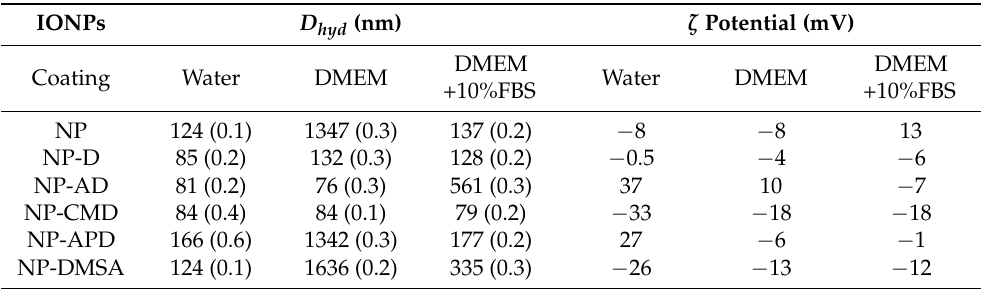
Table 1. Mean hydrodynamic diameters (with PDI in parentheses) and zeta potential values of IONPs suspended in water, DMEM cell culture medium and DMEM supplemented with FBS (10%). IONPs D hyd (nm) ζ Potential (mV) DMEM Coating Water DMEM Water DMEM +10%FBS NP 124 (0.1) 1347 (0.3) 137 (0.2) − 8 − 8 13 NP-D 85 (0.2) 128 (0.2) − 0.5 − 4 − 6 NP-AD 81 (0.2) 76 (0.3) 561 (0.3) 37 10 − 7 NP-CMD 84 (0.4) 84 (0.1) − 18 NP-APD 166 (0.6) 177 (0.2) − 6 − 1 NP-DMSA 124 (0.1) 335 (0.3) − 26 − 13 −